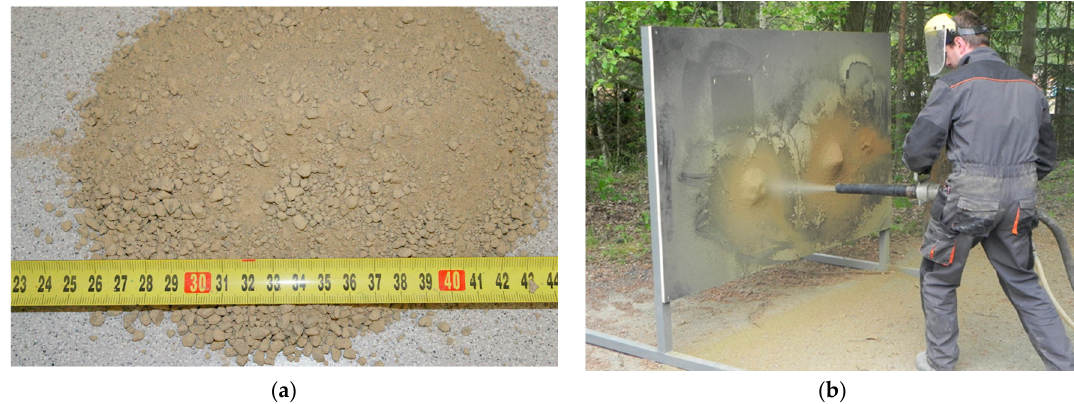
Figure 5. ( a ) Photograph of the B75 REC MIX I material; ( b ) spray testing on the testing